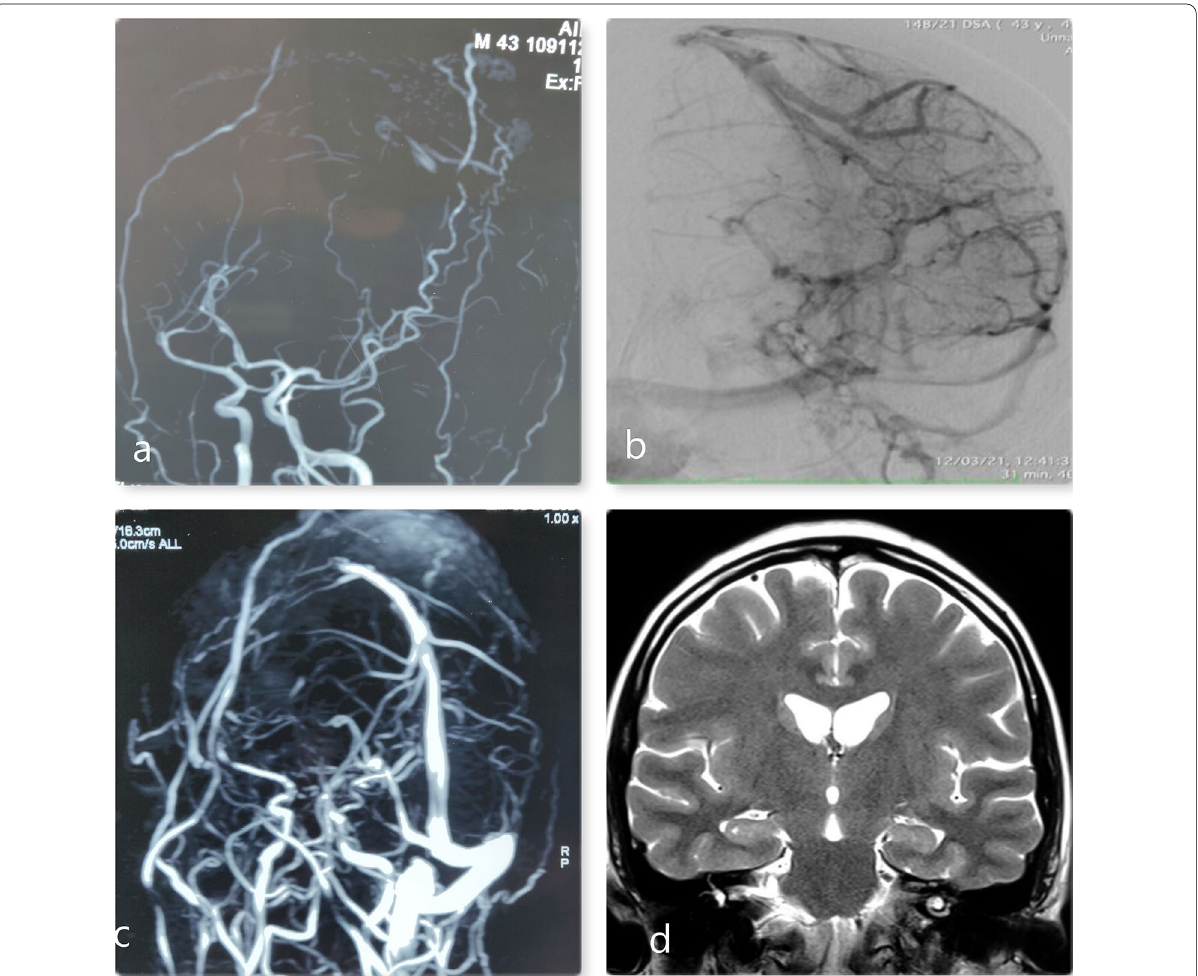
Fig. 2 a MR arteriography suggestive of tumour feeding artery from both External carotid artery. b Digital subtraction angiography suggestive of tumour Blush present suggesting vascular tumour. c MR angiography suggestive of no visualisation of anterior sagittal sinus and left transverse sinus. d Postoperative image shows no residual lesion on Coronal T2 weighted images following radiotherapy and